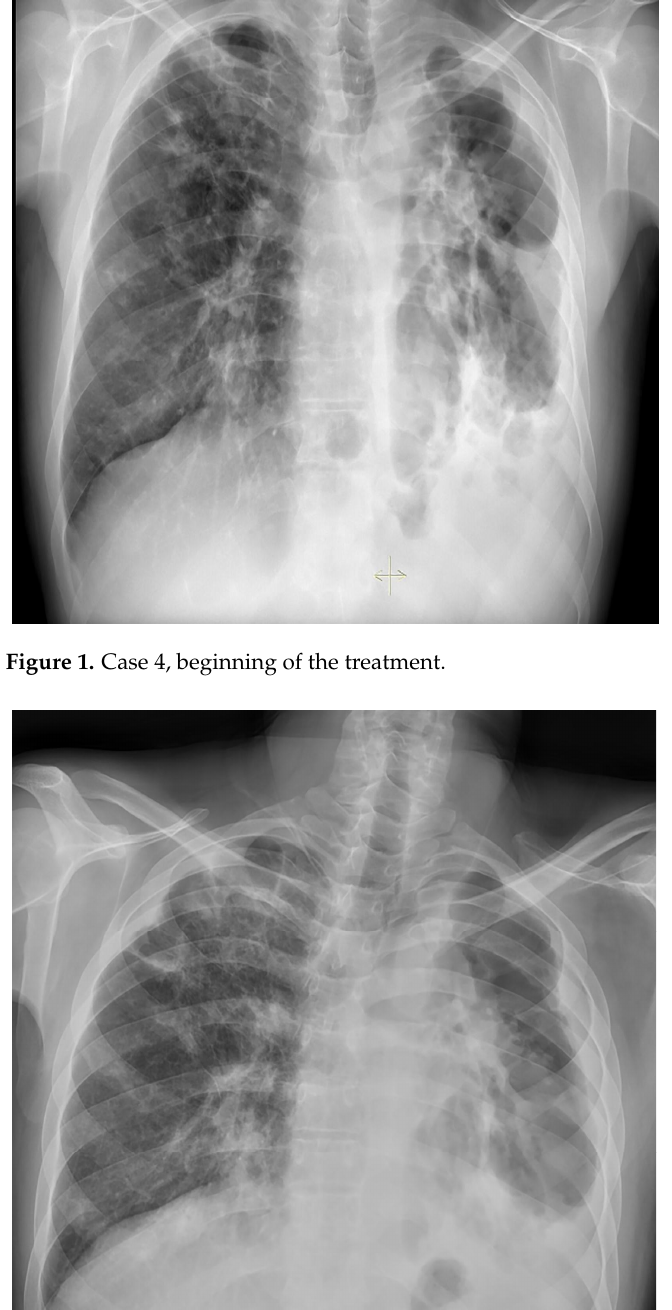
Figure 3. Case 7, beginning of the treatment.